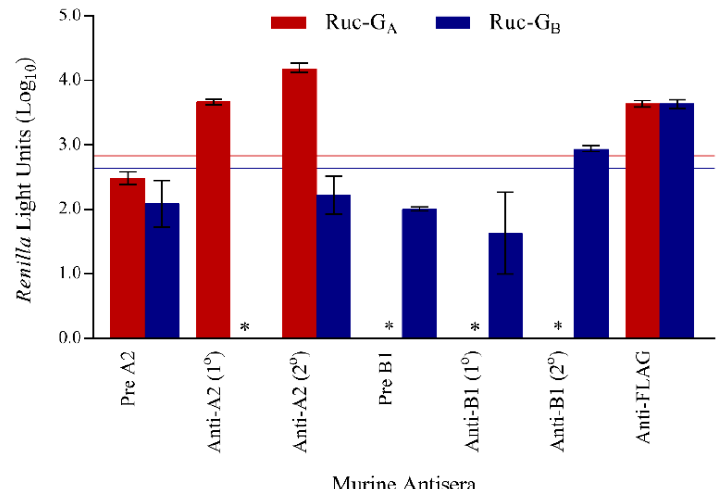
Figure 6. Detection of subtype-specific, anti-RSV-G IgG antibody responses. Murine immune responses were evaluated following primary and secondary intranasal infection with RSV-A2 or -B1. The mean reactivities against Ruc-G A and Ruc-G B antigens are shown in red and blue bars, respectively, and error bars represent standard deviations. Data were normalized against murine anti- FLAG antibody. Cutoff values for a positive signal were five standard deviations above the mean value of the negative control and are shown as horizontal red (Ruc-G A ) and blue lines (Ruc-G B ). * Represents a negative result.